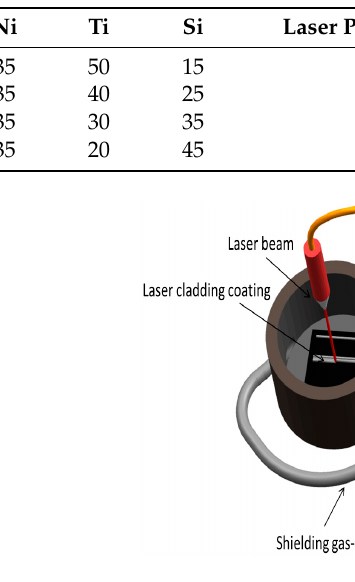
Figure 1. The schematic diagram of the shielded chamber.